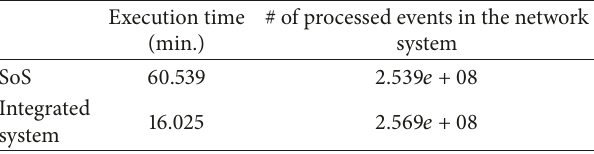
Table 5: Comparison of the simulation speeds of the SoS and the integrated system for